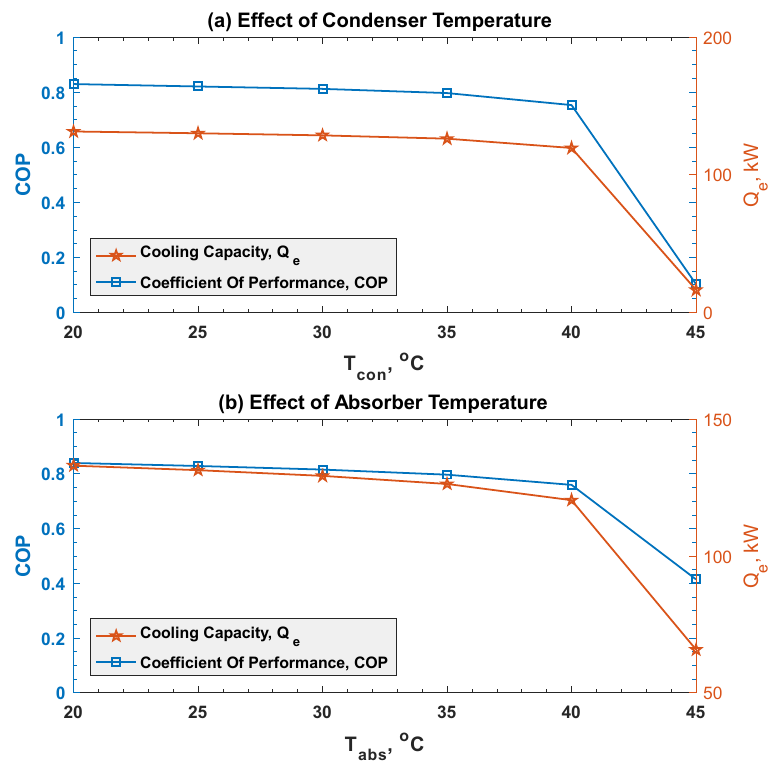
Figure 9. Condenser and absorber temperatures effects on chiller performance.